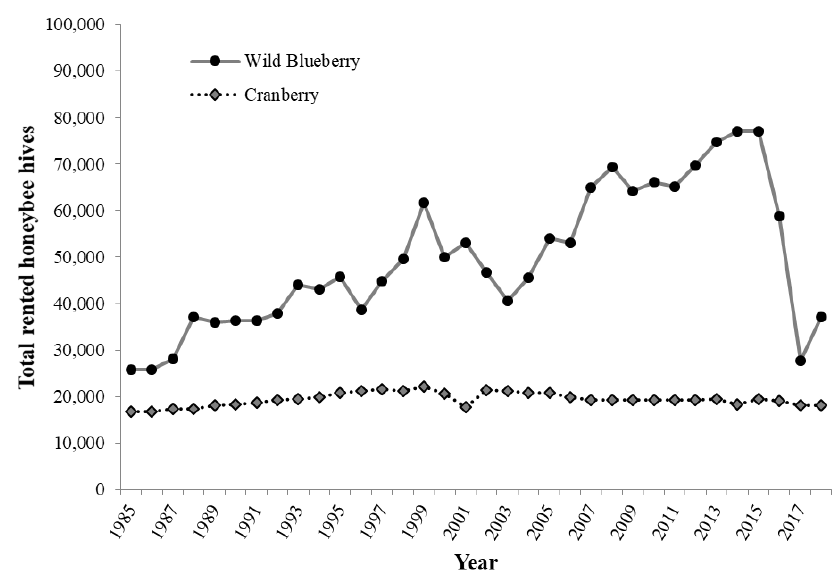
Figure 1. Production areas and regions for Massachusetts, United States (USA) cranberries (red) and Maine, USA, wild blueberries (blue).